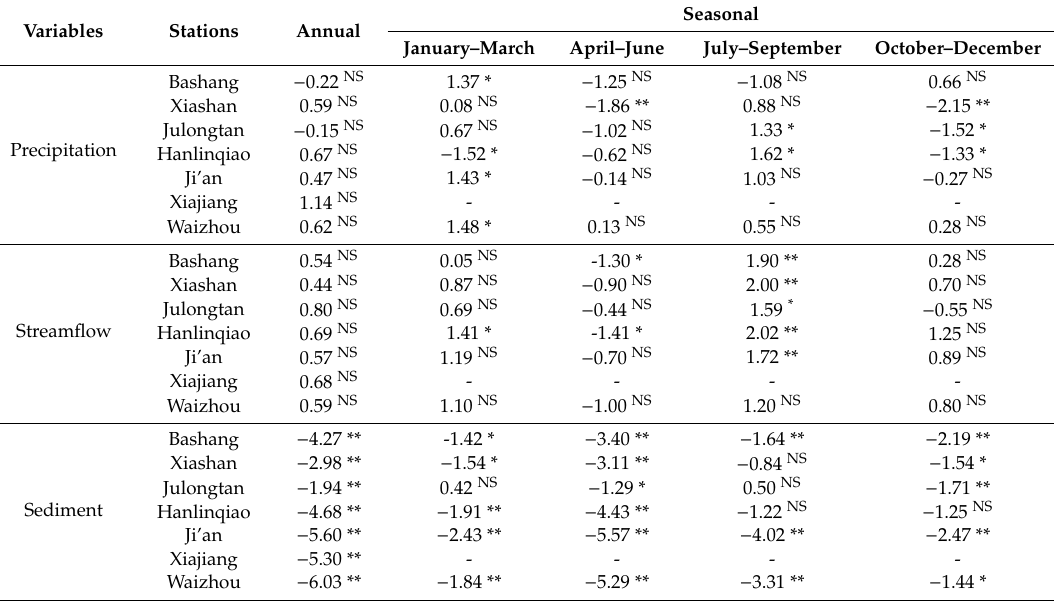
Table 3. The Mann–Kendall test (Z statistic) for the annual and seasonal changes of precipitation, streamflow, and sediment